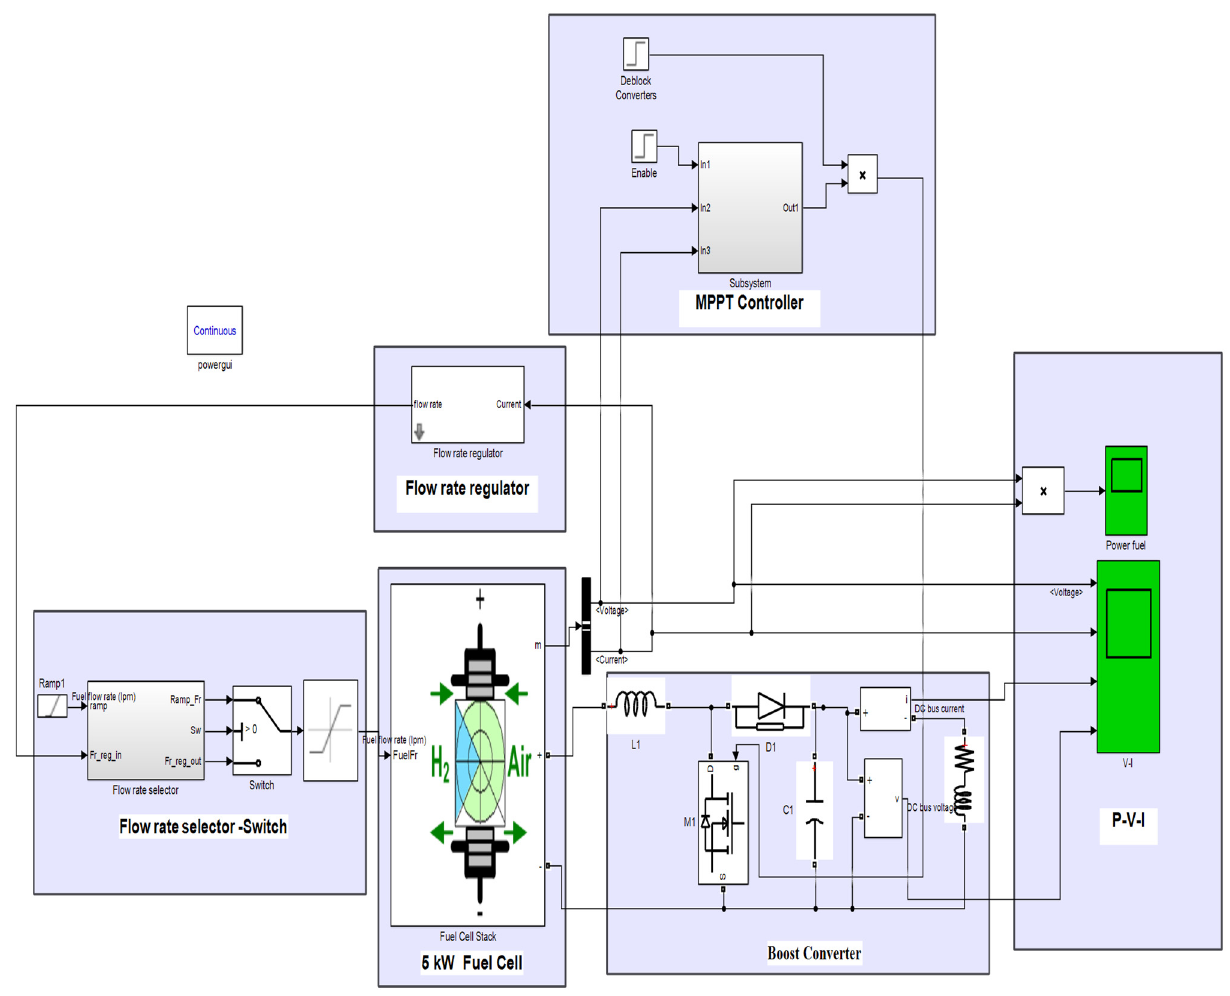
Figure 7. Study system with controller.